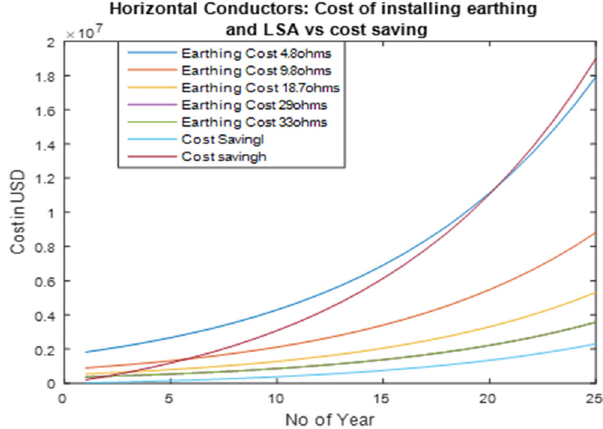
Figure 21. Break-even cost of earthing enhancement with line surge arrestors (LSAs) vs. cost saving over a 25 year period.